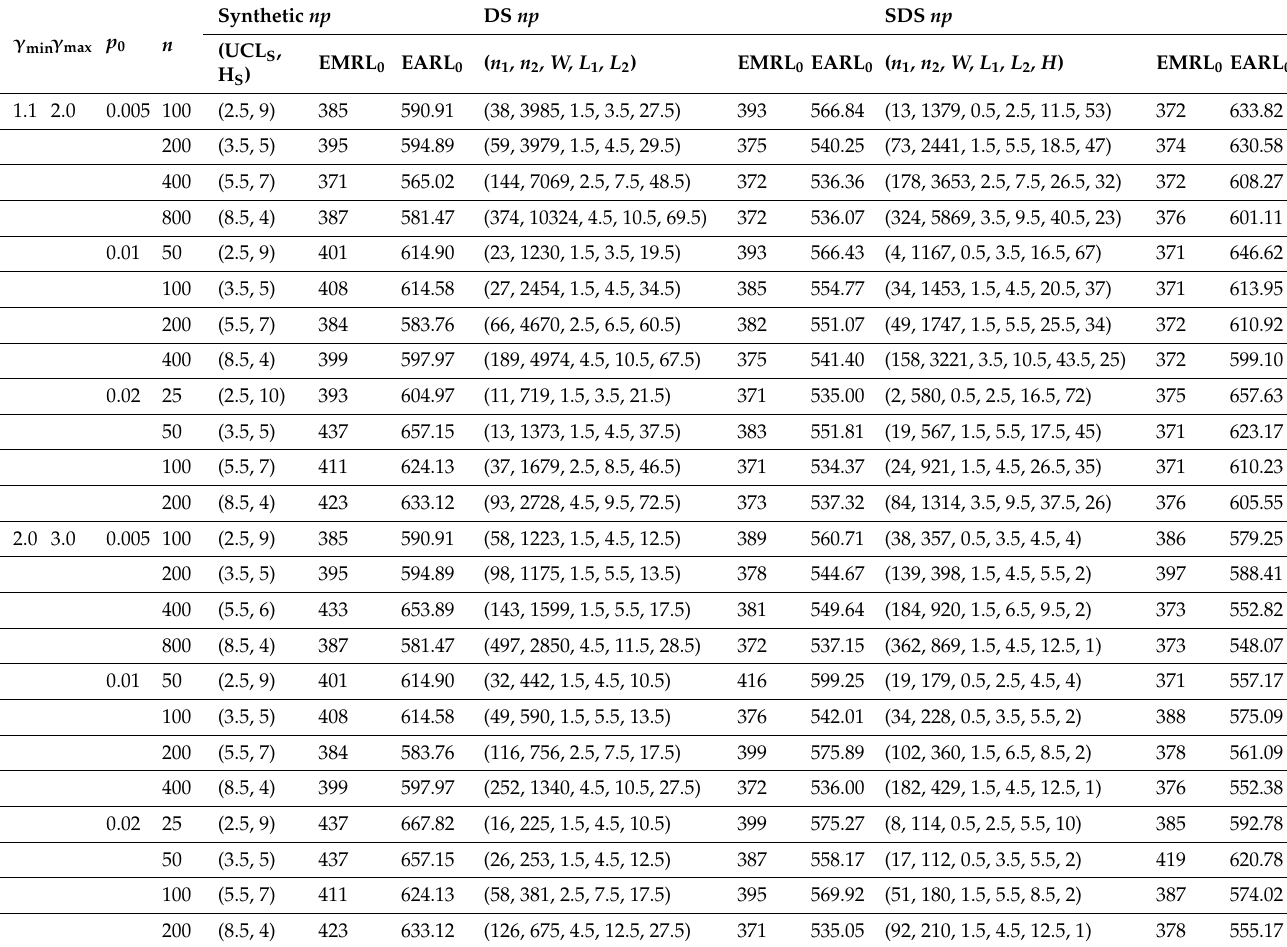
Table 3. Optimal charting parameters for the SDS np , synthetic np and DS np charts, based on EMRL, in ZS mode, together with their corresponding MRL 0 and ARL 0 values, when MRL 0min =